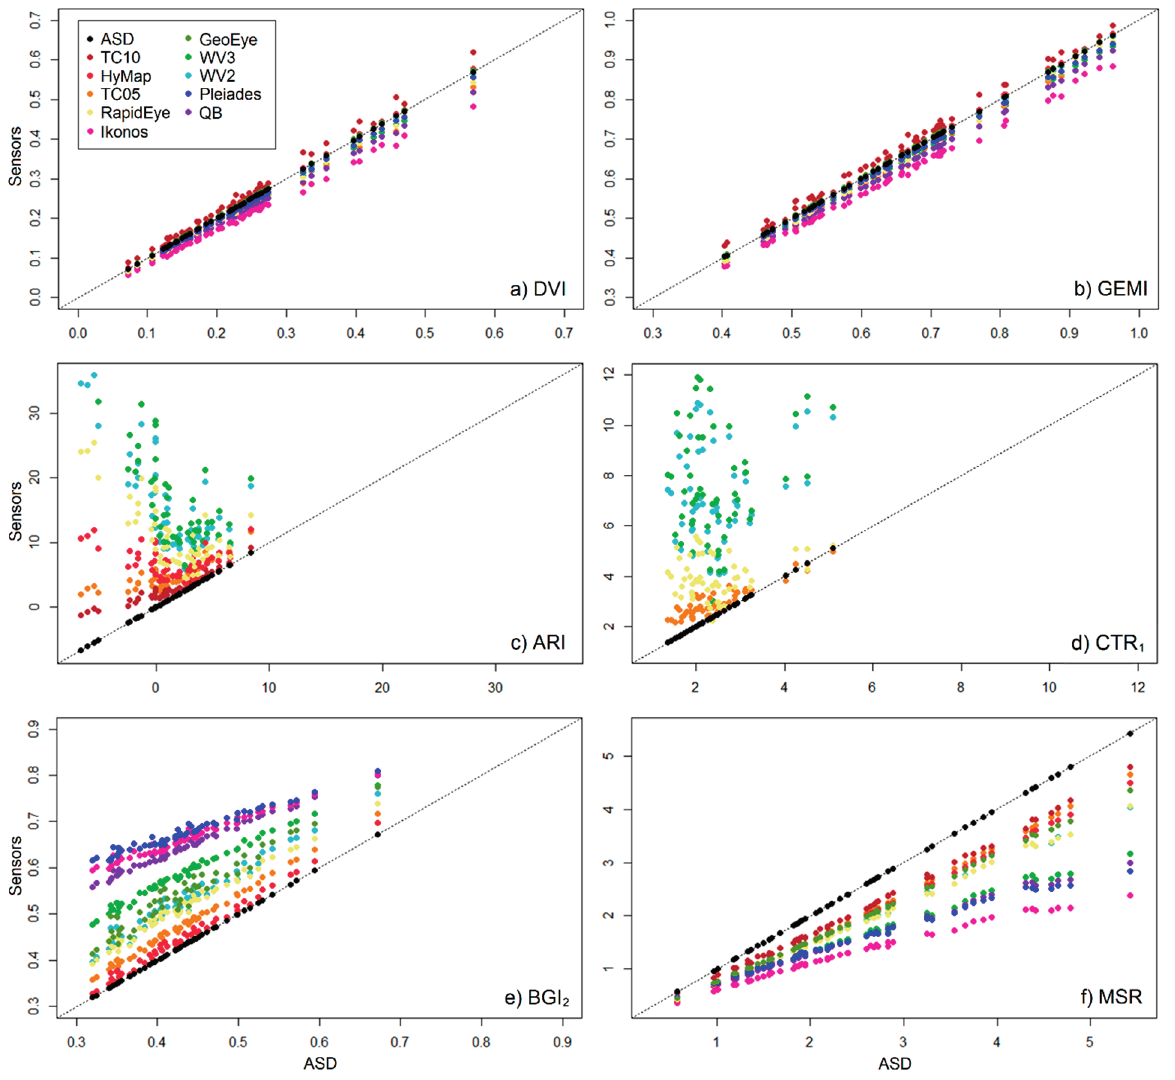
Figure 3. Scatterplots for representative indices, showing the relationships between the original ASD data and the spectrally simulated data of various sensors. ( a ) Difference Vegetation Index (DVI); ( b ) Global Environmental Monitoring Index (GEMI); ( c ) Anthocyanin Reflectance Index (ARI); ( d ) Carter Index 1 (CTR 1 ); ( e ) Blue/Green Index 2 (BGI 2 ) and ( f ) Modified Simple Ratio (MSR). The dashed line represents the 1:1